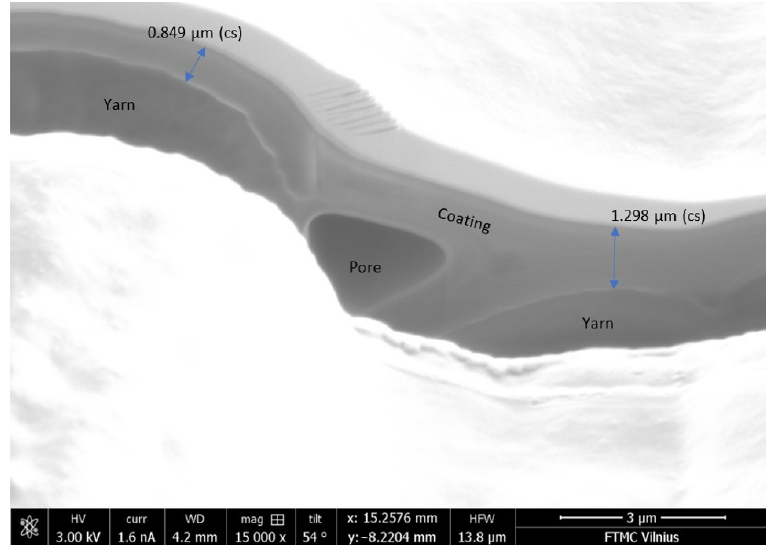
Figure 4. SEM image of S3C sample coated with PEDOT:PSS paste.